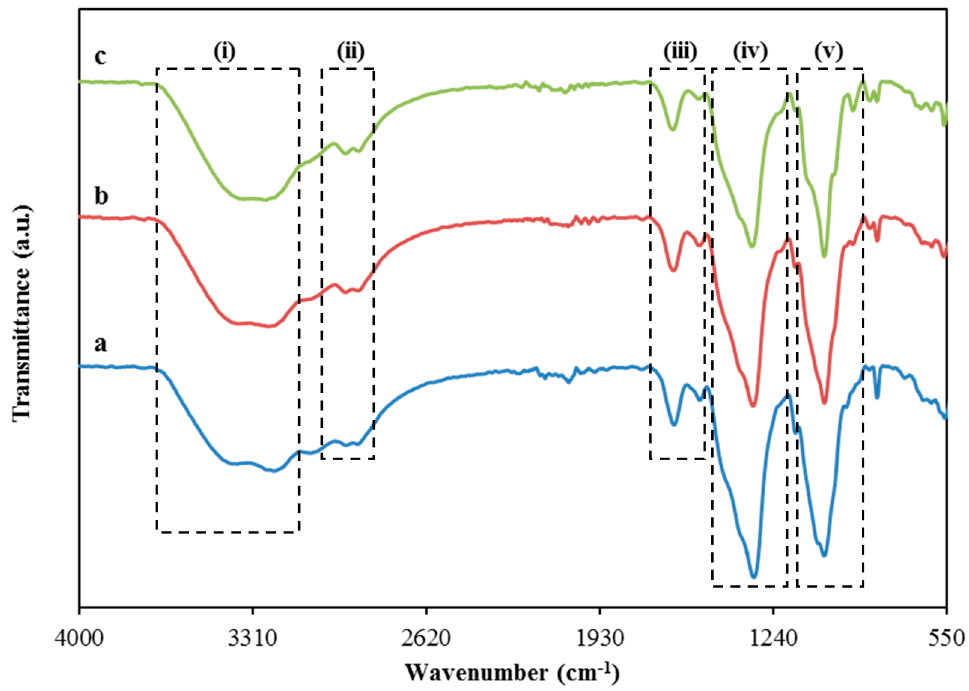
Figure 4 . Fourier transform infrared spectroscopy (FTIR) spectra for ( a ) CMNG1, ( b ) CMNG2 and ( c ) CMNG3.